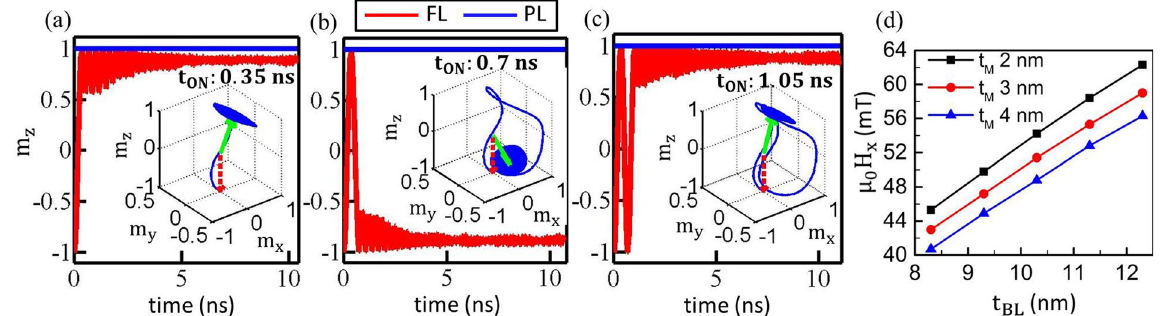
Figure 2. FL switching for a voltage pulse with t ON in integer multiples of the half precession periods (t Half ): t ON is ( a ) 0.35 ns, ( b ) 0.7 ns and ( c ) 1.05 ns while t Half is 0.35 ns. For the odd multiples the FL toggles while for the even cases it restores to the original state and remains unaltered. Insets show a full three dimensional (3D) FL dynamics for the respective cases, where the red dash arrow, green arrow and blue line is the initial m state, final m state and its trajectory, respectively. ( d ) Bias field acting on the FL along x-axis generated by the BL for different metal spacer thicknesses t M and BL thicknesses t BL . This large enough exchange field, e.g. 50 mT for t BL of 10 nm and t M of 3 nm, can bias the FL for precession based VCMA